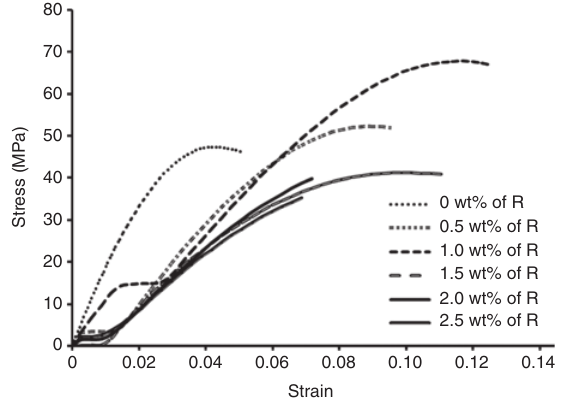
Figure 3 Stress strain curve of different weight percentages of DNR.